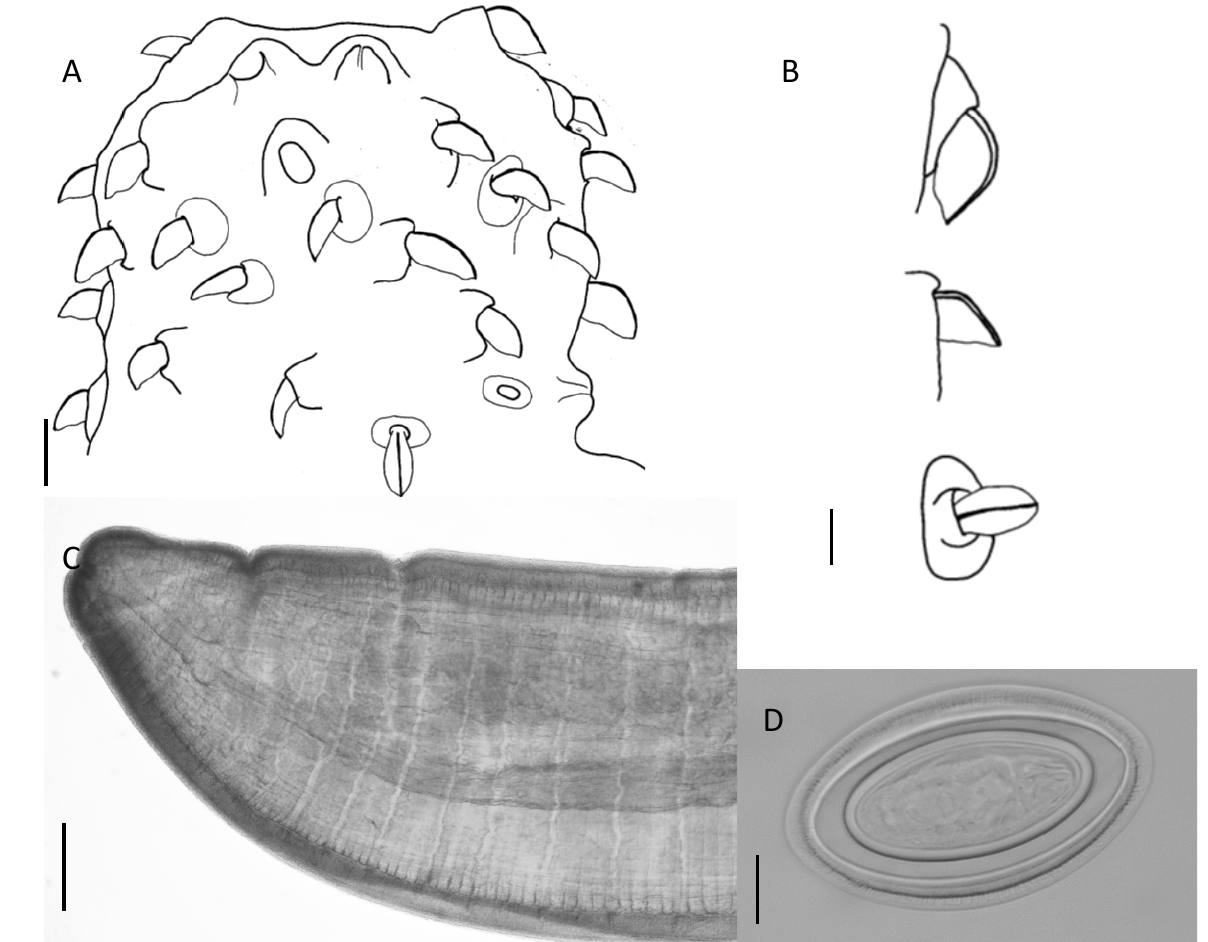
Figure 5. Oligachanthorhynchidae sp. collected from Manis javanica . Female specimens. ( A ) Line drawing of roboscis showing pattern of hooks. ( B ) Line drawing of hooks on proboscis; bottom hook is flattened against the proboscis. ( C ) Photomicrograph of posterior end, showing uterine bell. ( D ) Photomicrograph of egg dissected from body. Scale bars: ( A ). 40 µm. ( B ). 40 µm. ( C ). 500 µm. ( D ). 20 µm.